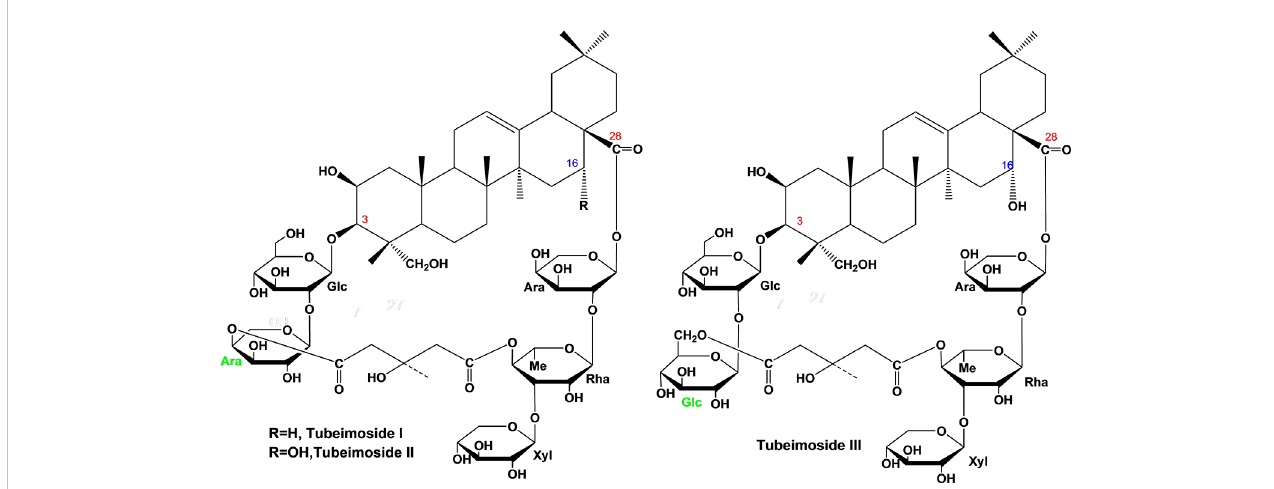
FIGURE 1 Chemical structure of three tubeimosides isolated from Rhizoma Bolbostemmatis. The chemical structures were identi fi ed by HR-ESI-MS and NMR. Ara, a -L-arabinopyranosyl; Glc, b -D-glucopyranosyl; Rha, a -L-rhamnopyranose; Xyl, b